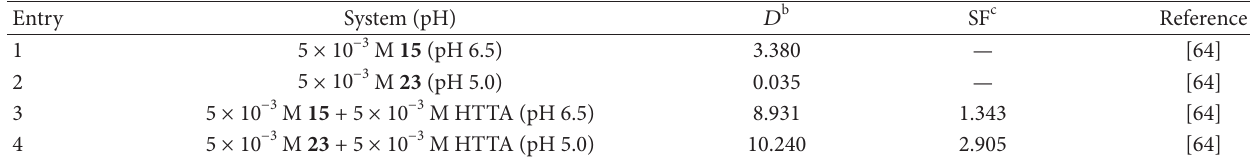
T 8: e synergistic coefficients of UO 22+a